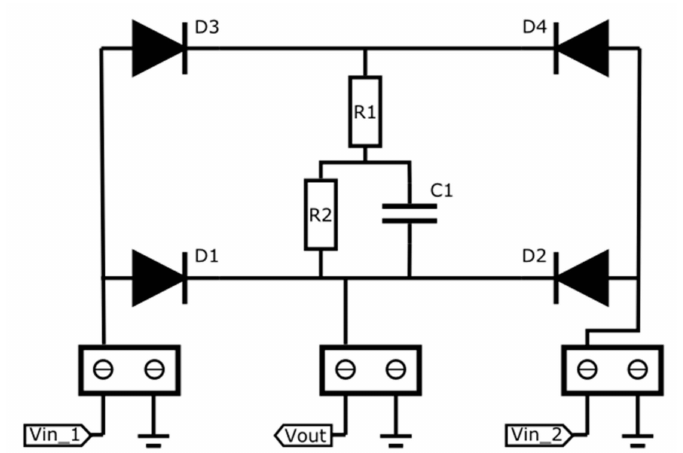
Figure 4. This diode-based circuit allows the implementation of a dual power supply system, switching between Vin_1 and Vin_2 depending on the higher voltage. It uses Schottky diodes with low dynamic resistance and very low reverse current to minimize the power transfer between the two power